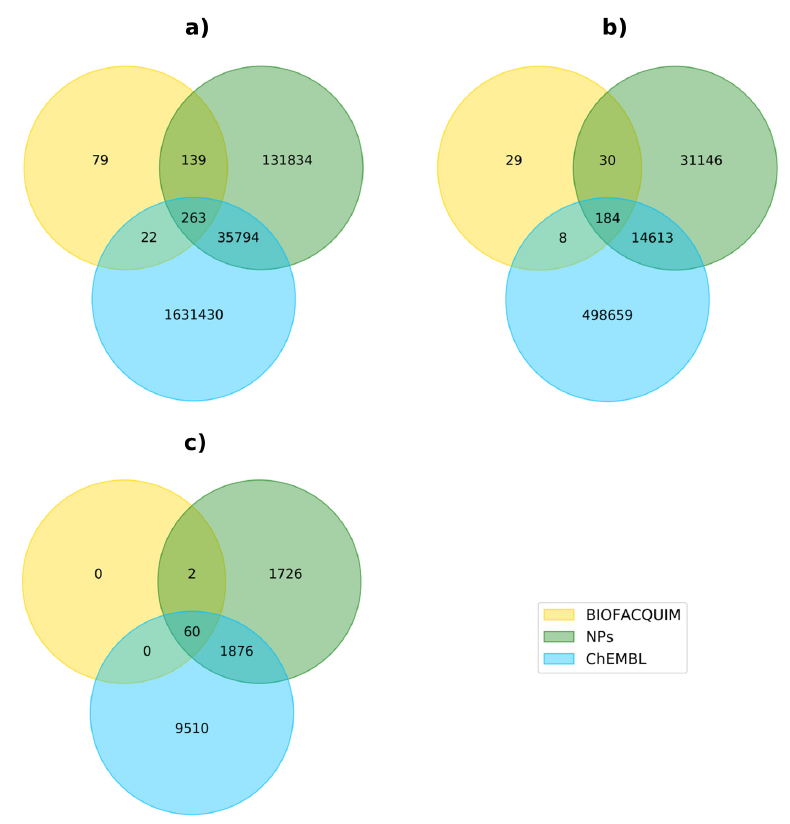
Figure 1. Overlap between BIOFACQUIM, reference natural products (NPs) and ChEMBL. Datasets content was analyzed in terms of ( a ) Compounds, ( b ) Scaffolds and ( c ) Functional